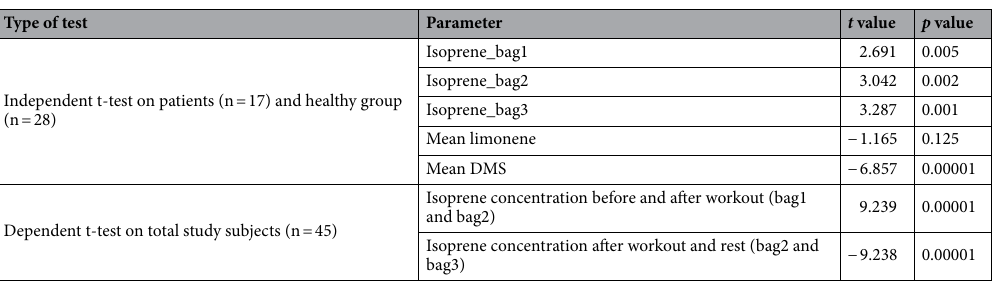
Table 2. Breath test parameters and t-test result.